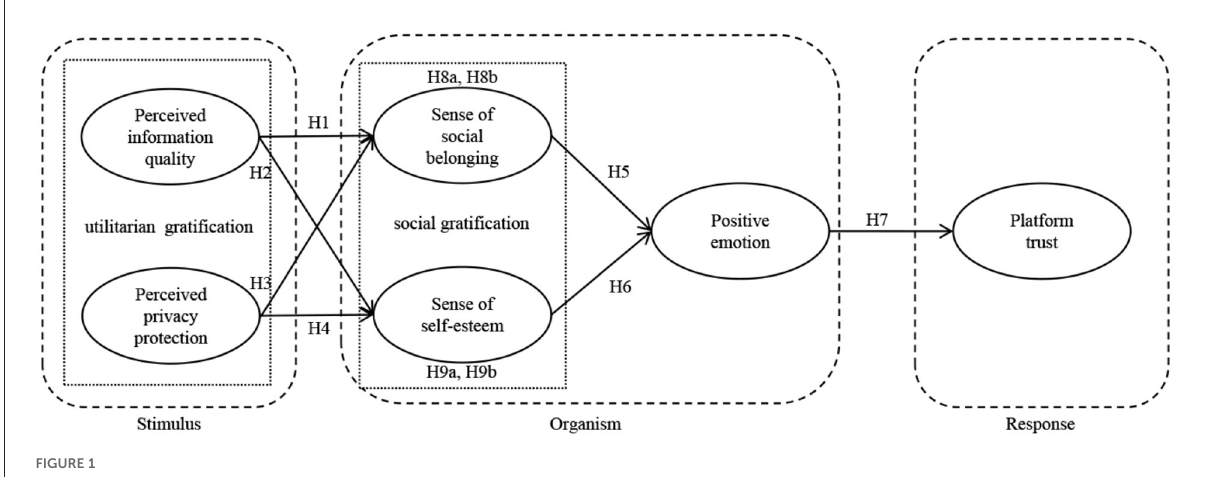
FIGURE1 Theoretical